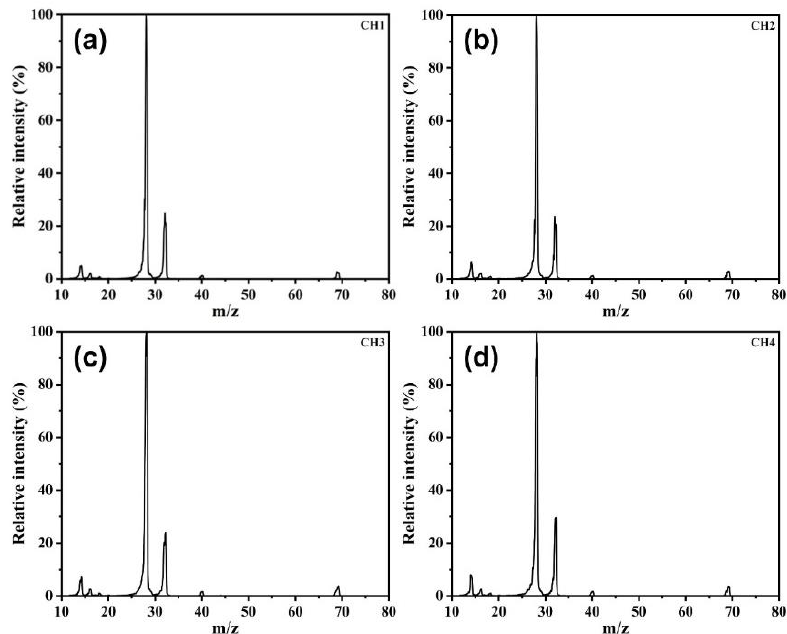
Figure 5. ( a ) Mass spectrum of air sample in channel 1. ( b ) Mass spectrum of air sample in channel 2. ( c ) Mass spectrum of air sample in channel 3. ( d ) Mass spectrum of air sample in channel 4.